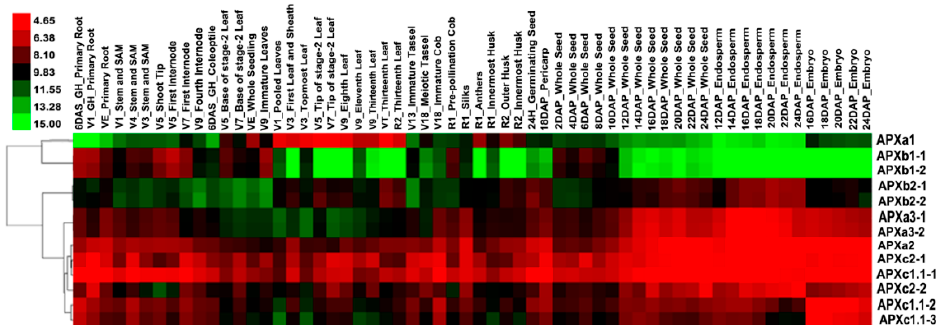
Figure 5. The expression patterns of APX s in tissues of maize at different growth and development stages. The data of expression levels of maize APX genes in different tissues were derived from ZM37 in PLEXdb [32]. Colous represent expression levels for each gene which are either above (red), below (green), or at the mean expression level (black). Different tissues are mentioned on top, while the genes are mentioned on the right.